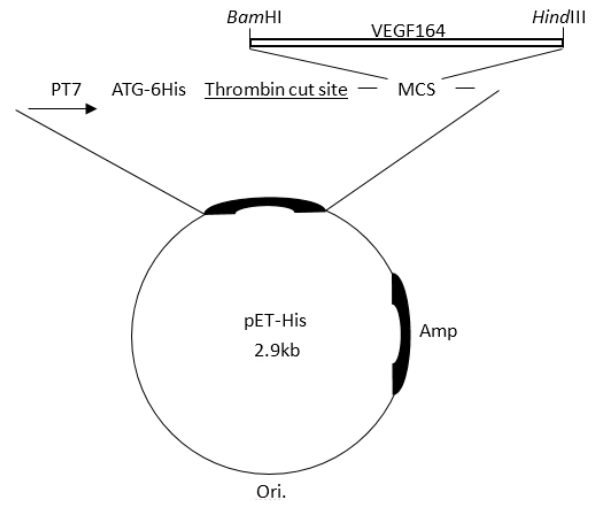
Figure 1. Schematic of insertion of goat VEGF164 cDNA into pET-his. VEGF, vascular endothelial growth